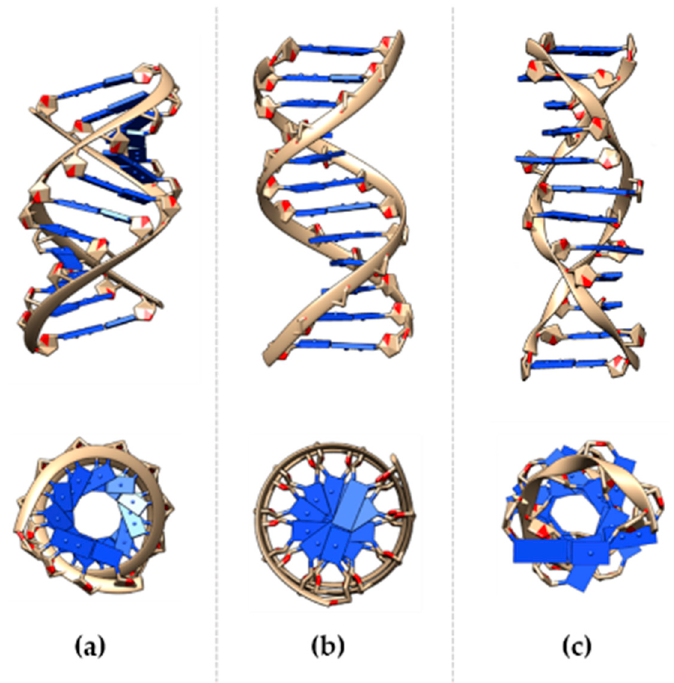
Figure 1. DNA helix in the ( a ) A-, ( b ) B-, and ( c ) Z-form lateral and upper view. A- and B- DNA structures were built and viewed using the program Chimera [3] for the arbitrary sequence ATCGATCGATCG; Z-form refers to the dodecamer TCGCGCGCGCGCG [4]. Right-handed A- or B-DNA, and left-handed Z-helices show different